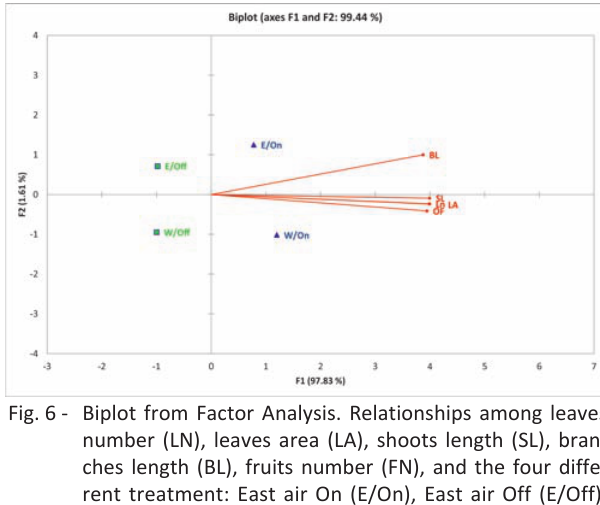
Fig. 6 - Biplot from Factor Analysis. Relationships among leaves number (LN), leaves area (LA), shoots length (SL), bran- ches length (BL), fruits number (FN), and the four diffe- rent treatment: East air On (E/On), East air Off (E/Off), West air On (W/On), West air Off (W/Off); cv. Arbequina, Tombolo farm,